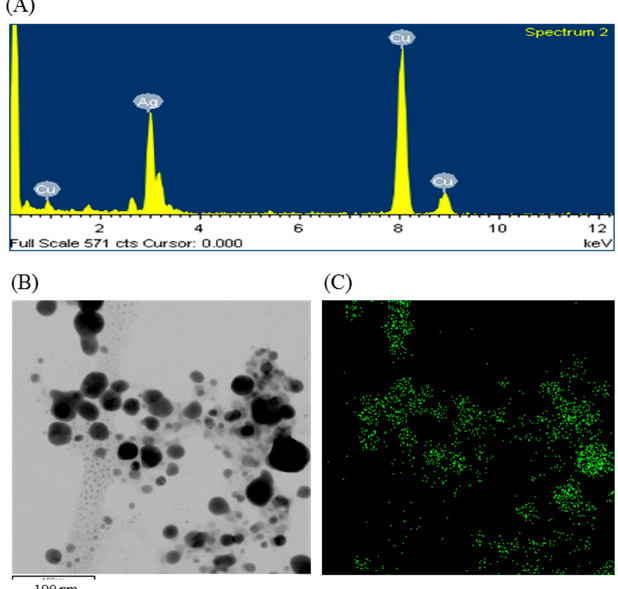
Figure 4. Energy dispersive X-ray (EDX) spectrum of ecofriendly synthesized AgNPs ( A ); TEM image (electron micrograph region) used for mapping ( B ); and the distribution of silver in elemental mapping ( C ).